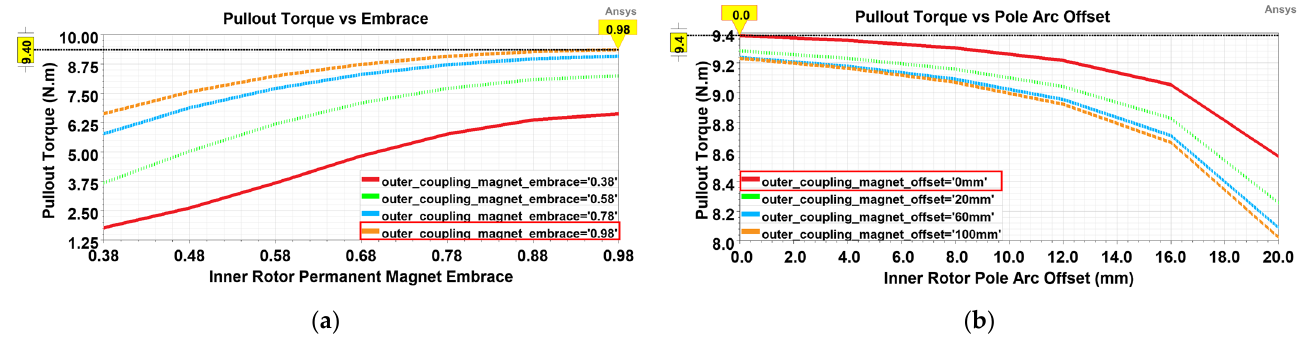
Figure 12. Pullout torque versus: ( a ) PM embrace; ( b ) PM offset.